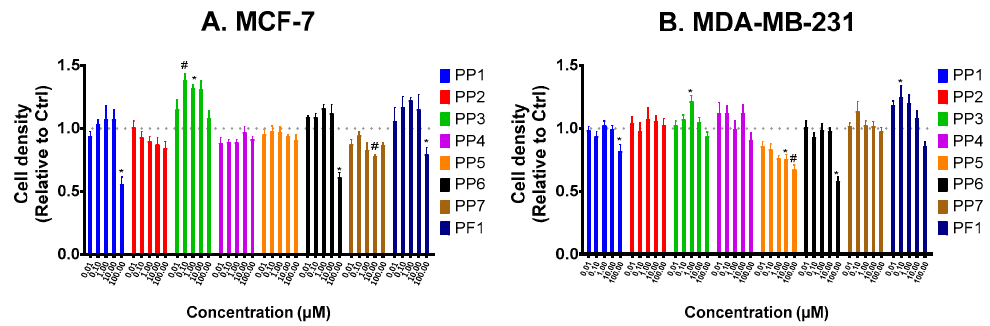
Figure 2. PP6 reduces cell survival of both MCF-7 and MDA-MB- 231 cells. MCF-7 ( A ) and MDA-MB-231 ( B ) were seeded in 96-well plates and treated with increasing concentrations (0.01–100 µM) of PhytoPs (PP1-7), PhytoF (PF1) or vehicle alone (Ctrl) in 1% FBS media for 48 h. Cell density was later determined with crystal violet stain. All treatment values were normalized against the Ctrl group. The following symbols denote a statistical significance when compared to the control group: *, p < 0.05, # p < 0.01.